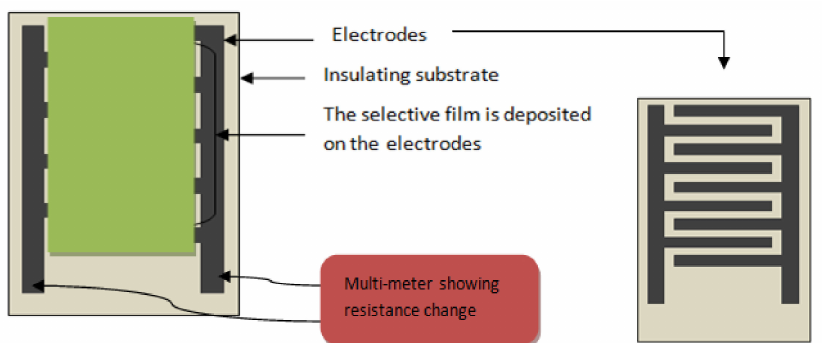
Figure 1. Types of H 2 S gas sensors.